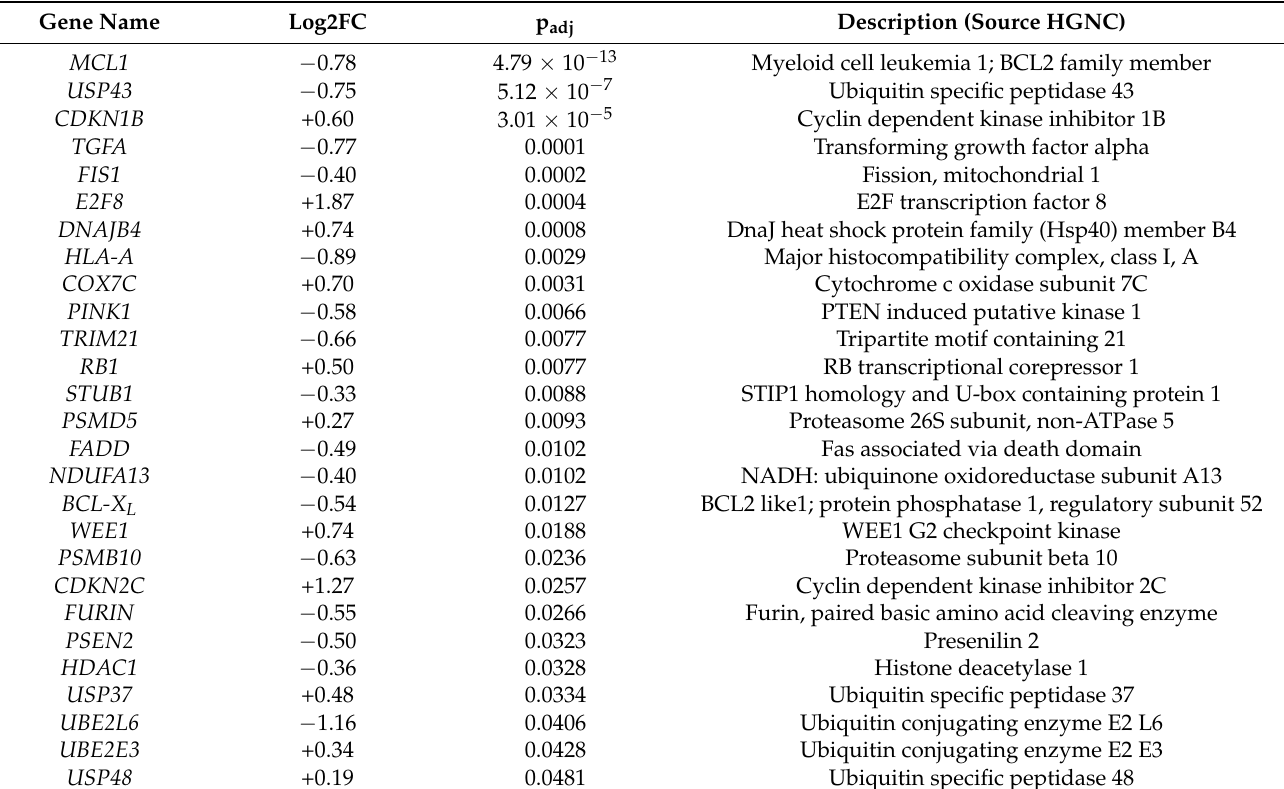
Table 1. List of selected significantly differentially expressed genes. The criteria for inclusion were p adj < 0.05 from the RNA sequencing analysis and gene function associated with pathways inferred in the text and linked to ANO1 signaling, including mitochondrial and ubiquitination functions. Genes are listed in ascending order of p adj value. Human Gene Nomenclature Committee